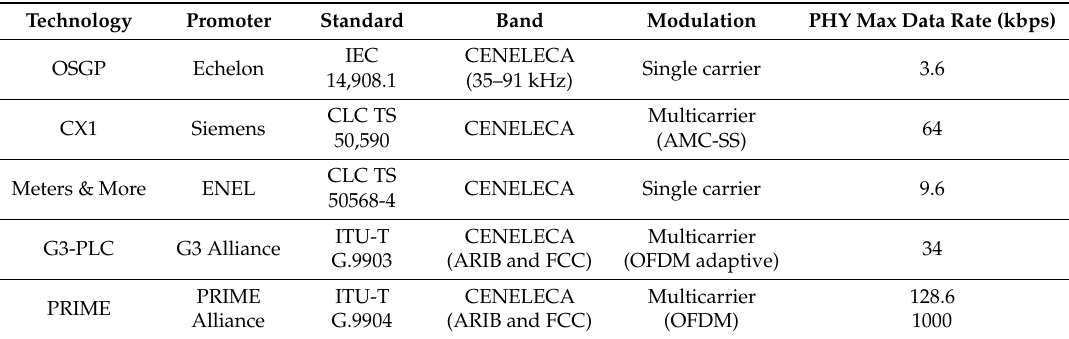
Table 1. Summary of Narrowband Power Line Communication (PLC) Technologies